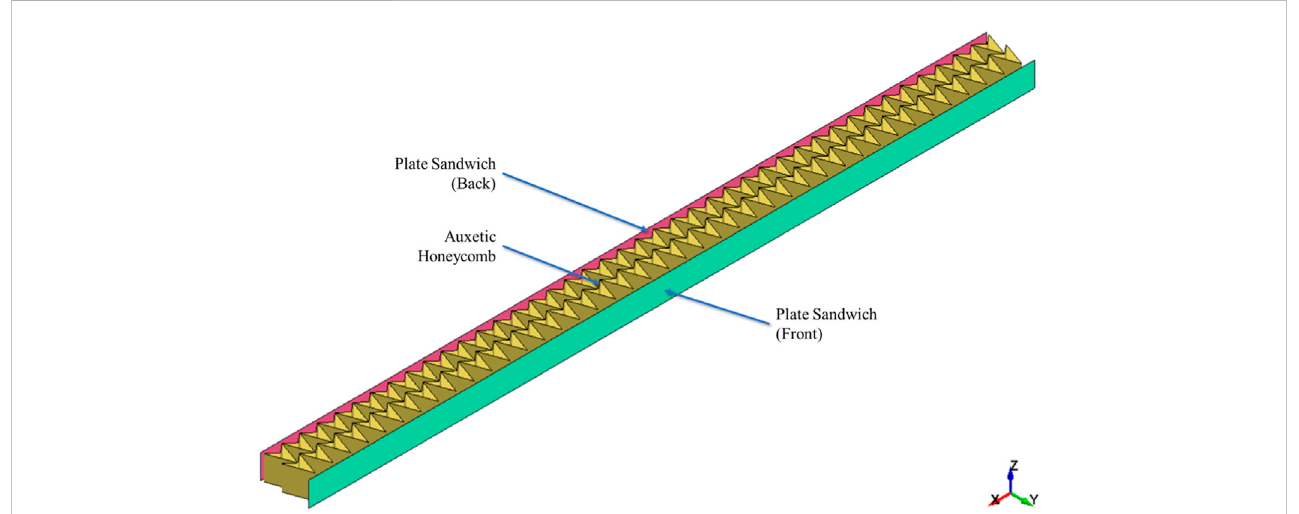
Sandwich structure, consisting of plate sandwich (red and green) and auxetic honeycomb (yellow).